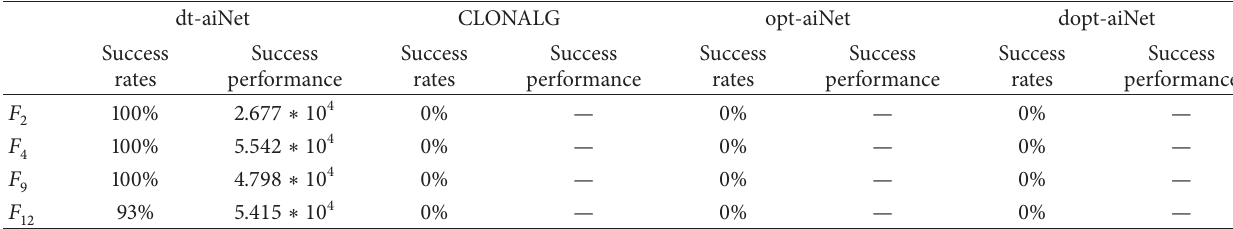
Table 6: Results (success rates) in 10-dimensional